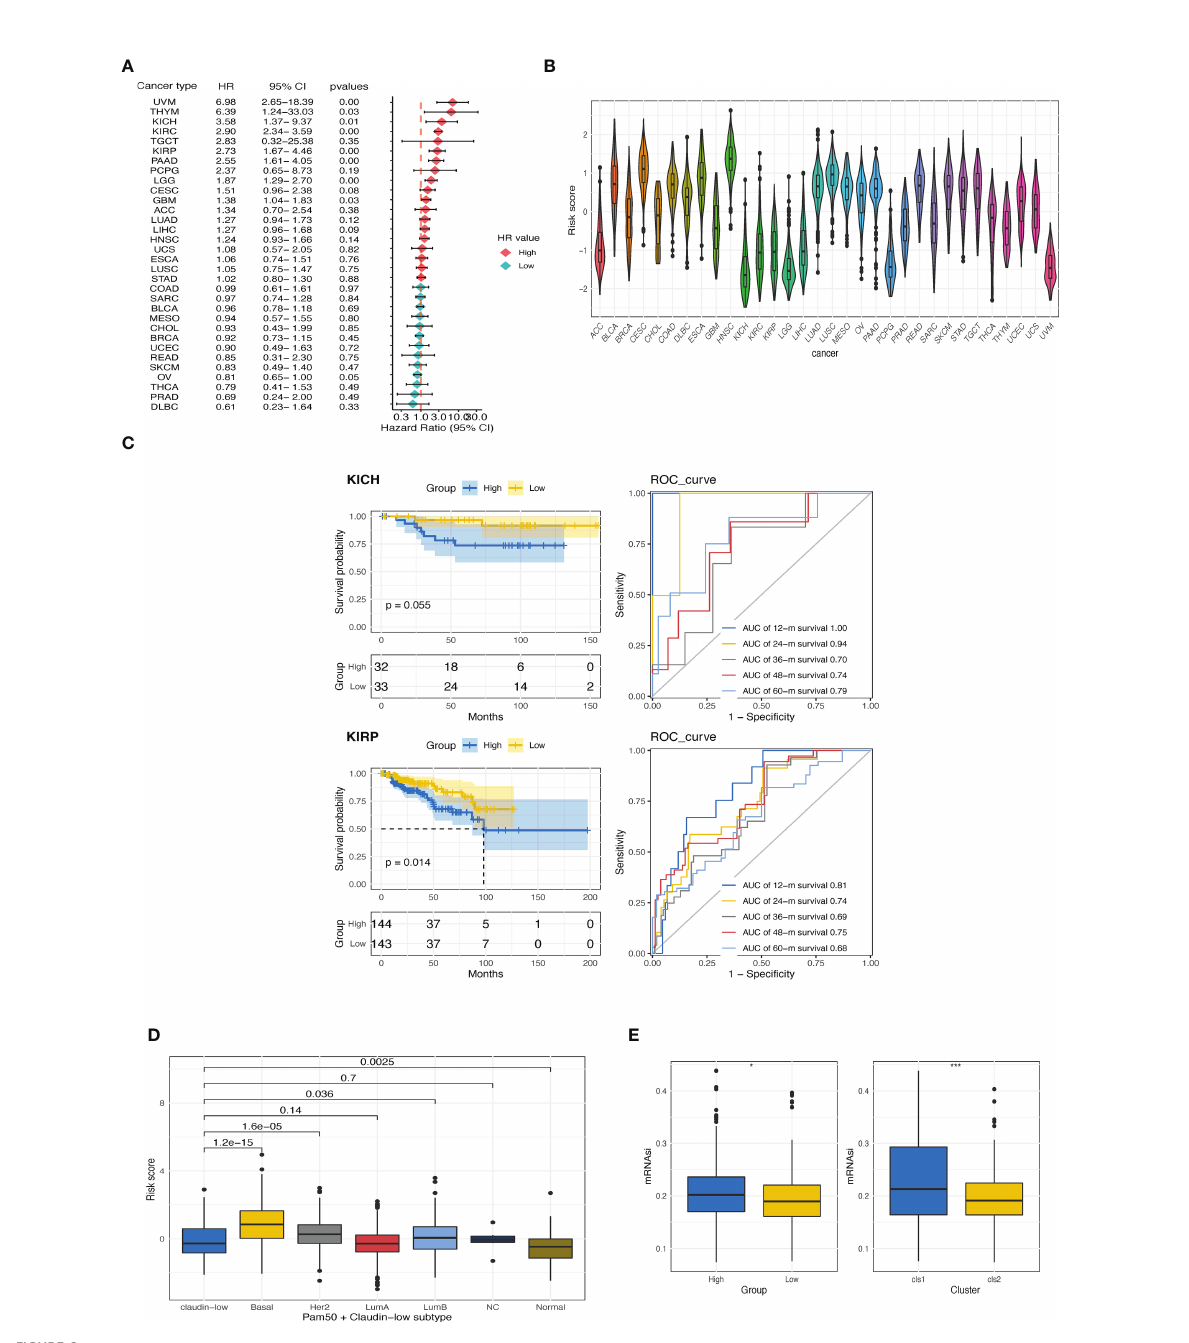
FIGURE 6 Exploration of CTR score in pan-cancer. (A) Forest plot of hazard ratios (HR) for the claudin-TME related (CTR) score in pan-cancers datasets from The Cancer Genome Atlas (TCGA) cohort. (B) Distribution of CTR scores among pan-cancers. (C) Kaplan – Meier curves and time-dependent area under the curve (AUC) value in the TCGA-kidney chromophobe (KICH) (upper) and TCGA-kidney renal papillary cell carcinoma (KIRP) (bottom) cohorts. (D) Difference in CTR scores between claudin-low and other subtypes of breast cancer in the METABRIC cohort. (E) Difference in the mRNA expression-based stemness index (mRNAsi) score between high and low CTR groups or between two clusters in the TCGA-kidney renal clear cell carcinoma (KIRC) cohorts. *p<0.05, ***p<0.001. KIRC, kidney renal clear cell carcinoma; KIRP, Kidney renal papillary cell carcinoma; KICH, kidney